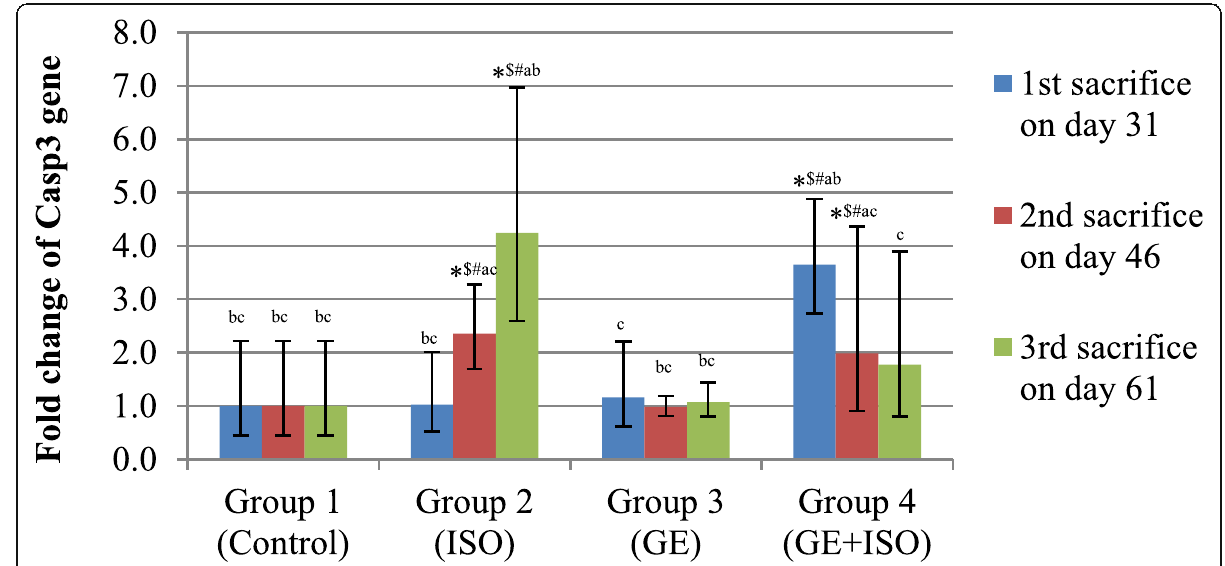
Fig. 5 Relative expression (2 - ΔΔ CT ) of Casp3 gene. In Group 1 the same data of the day 31 was used for day 46 and 61 as this group was neither GE nor ISO administrated. Data are presented as fold change with fold difference from the control group. The error bars indicate fold change differences as a range of Casp3 gene. One-way ANOVA (analysis of variance) along with LSD post hoc test was used to analyze the 2 - ΔΔ CT values between different groups. For ANOVA the data of fold change differences were used. The findings were considered as statistically significant, if p < 0.5 . * , $ and # indicate the fold change of CASP3 gene significantly different from Group 1 (control group) on the day of rat sacrifice i.e. day 31, 46 and 61 respectively and similarly a , b and c indicate fold change of CASP3 gene significantly different from Group 2 on the day of rat sacrifice i.e. day 31, 46 and 61